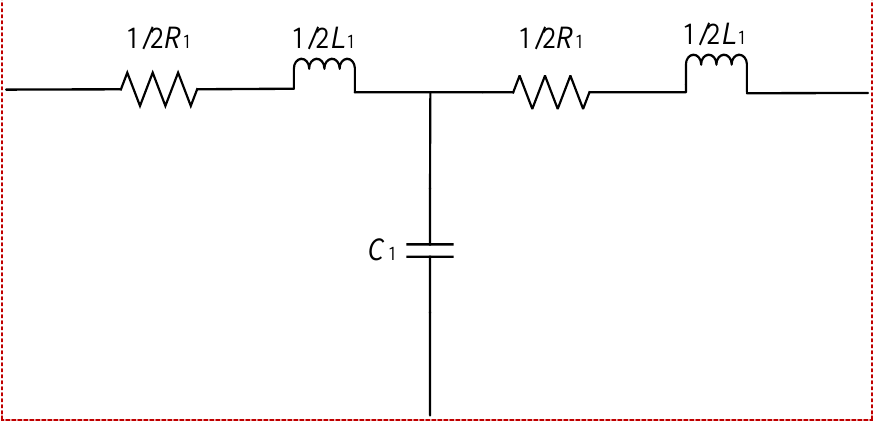
Figure 3. Equivalent model of the catenary.